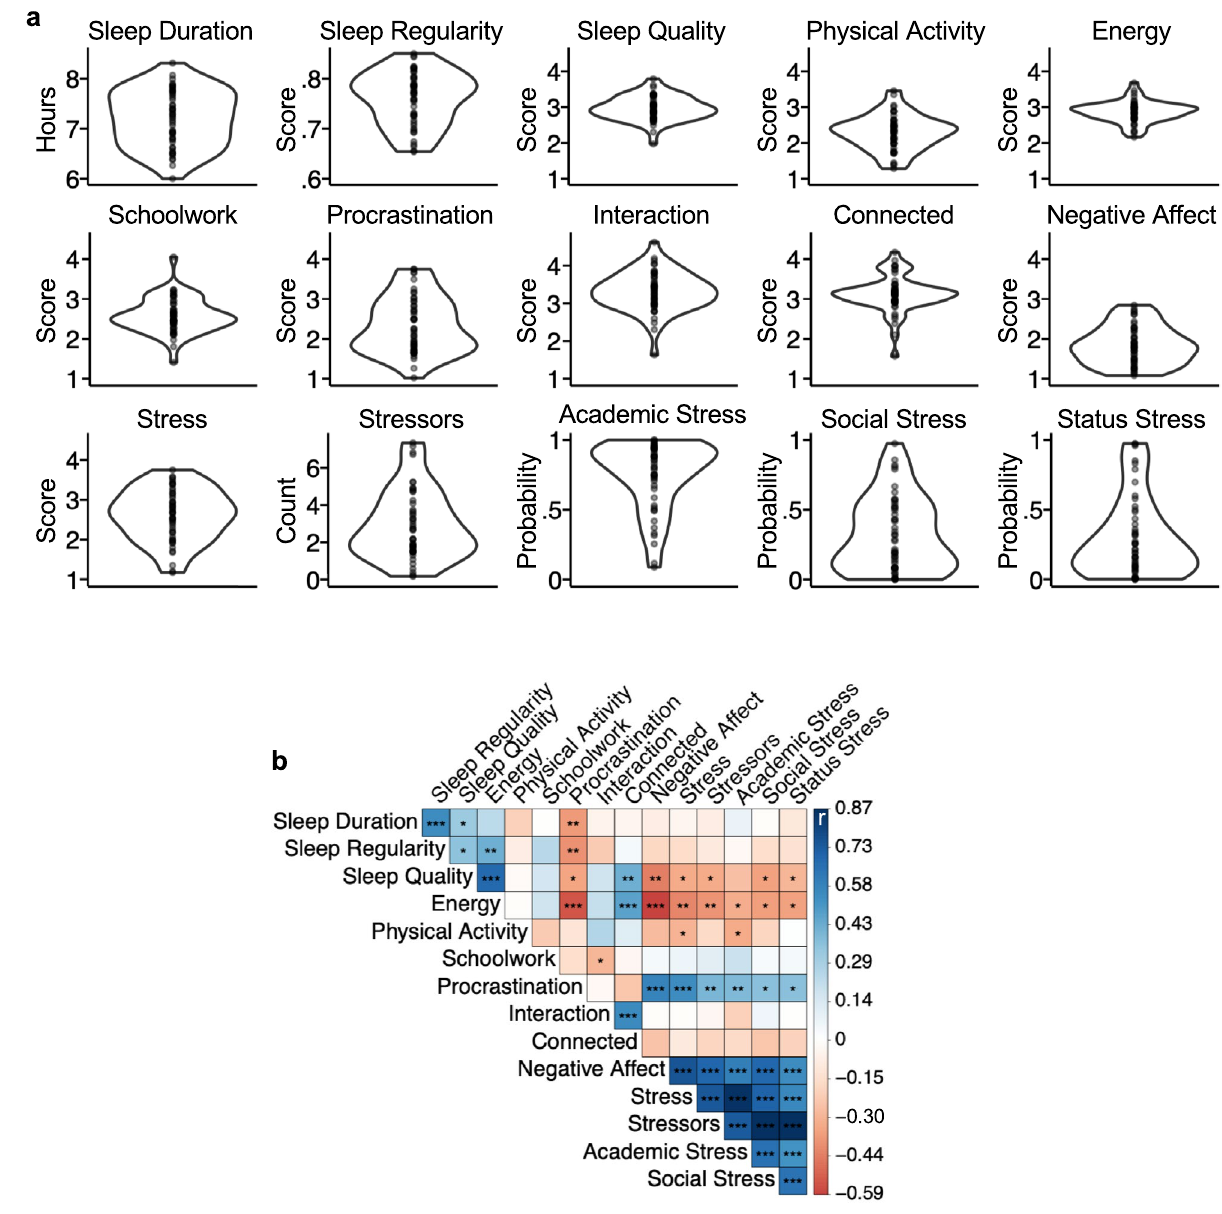
coefficients; stars represent statistical significance (*p < 0.05, **p < 0.01, ***p <